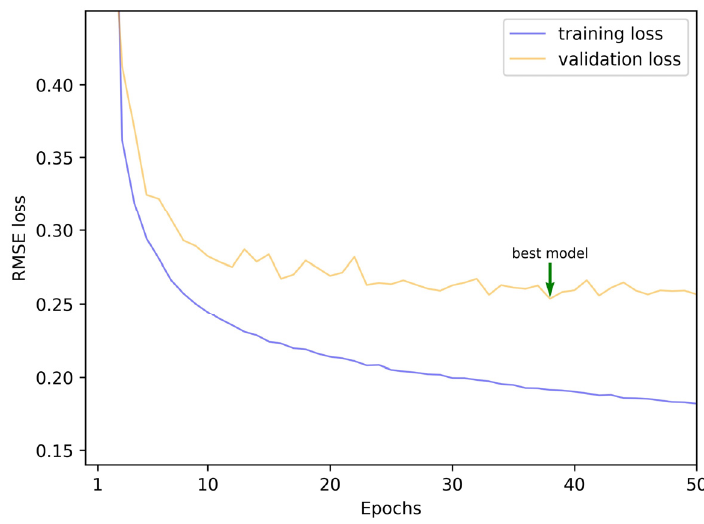
Figure 3. RMSE loss against epochs for the 3D U-Net model.